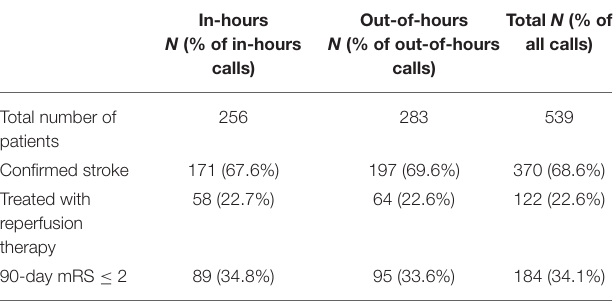
TABLE 2 | Patients confirmed to have suffered a stroke and treated with reperfusion therapy (thrombolysis or MT), in- vs. out-of-hours. In-hours N (% of